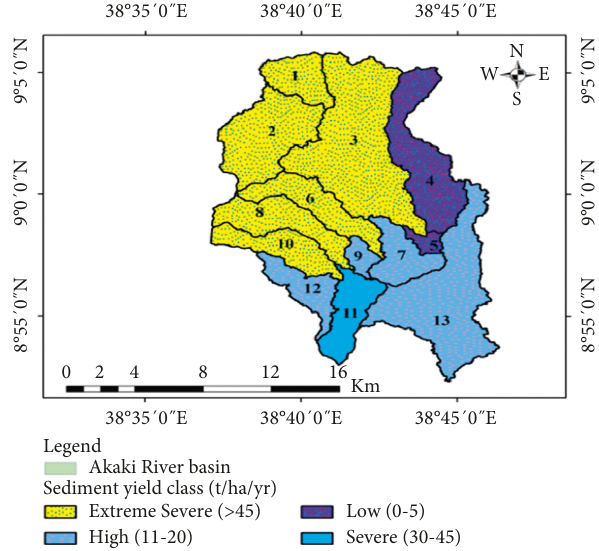
Figure 7: Spatial variability map of sediment yield in Akaki catchment.